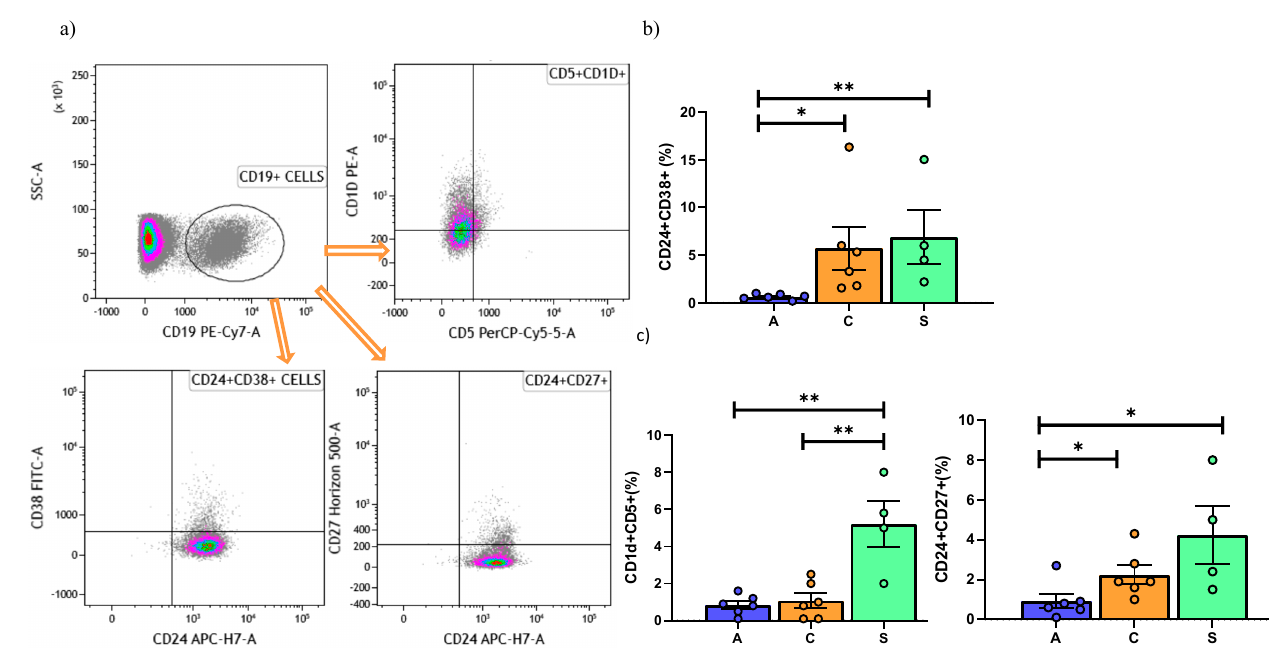
Figure 5. ( a ) Gating strategy used to analyze B reg cells detection. ( b ) Data represent individual values on PBMC, mean (center bar) ± SEM (upper and lower bars). If not indicated, p value is not significant. * p < 0.05, ** p < 0.01. ( c ) Data represent individual values on BAL, mean (center bar) ± SEM (upper and lower bars). If not indicated, p value is not significant. * p < 0.05, ** p < 0.01. Abbreviations: A: acute, C: chronic, S: stable.